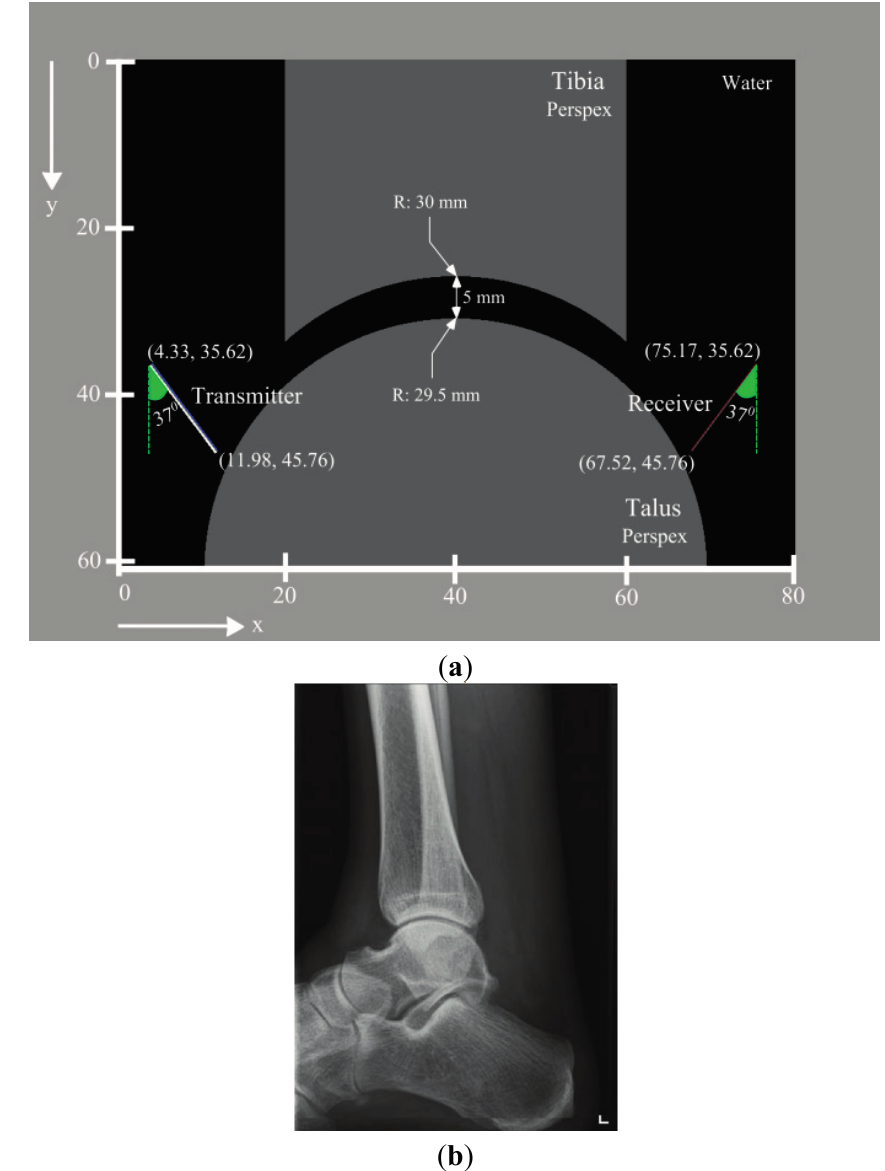
Figure 1. ( a ) Representation of the reference simulation model. Joint space width of the ankle is 5 mm. The radii of the tibial and talar arcs respectively are 30 mm and 29.5 mm. US probes are positioned in a nearly identical manner to the experiment; ( b ) Radiograph of a healthy ankle joint—Lateral view